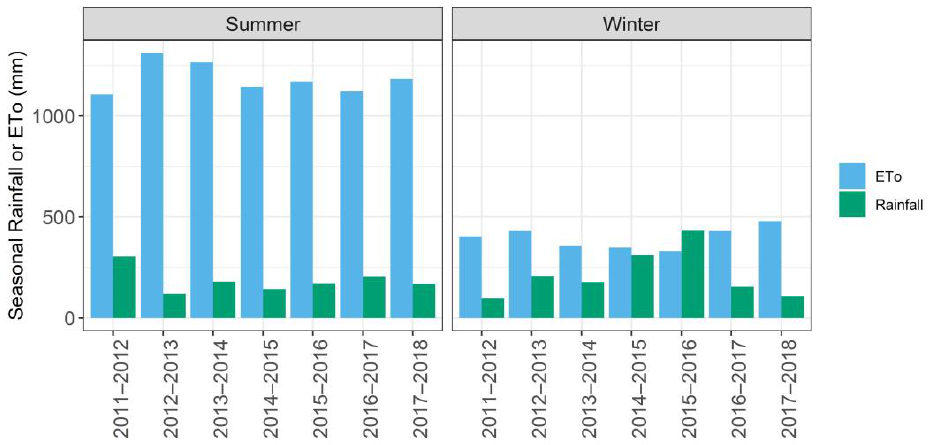
Figure 2. Summer and winter rainfall as well as the ETo from 2011 to 2018 in the CIA. The summer ETo and rainfall were the accumulation of the daily ETo and rainfall from October to March, respectively, and the winter ETo and rainfall were the accumulation of the daily ETo and rainfall from April to September, respectively.